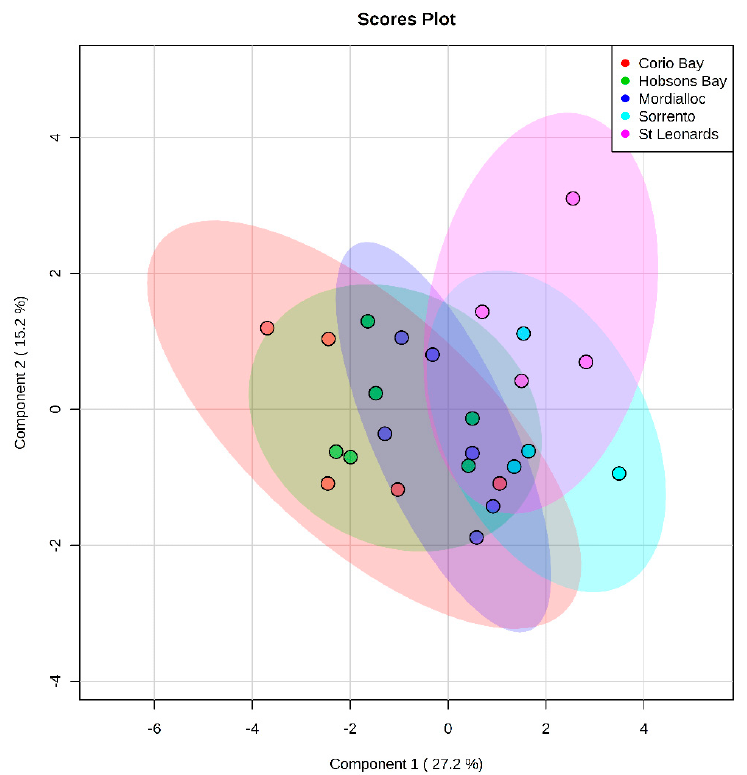
Figure 4. Partial least squares discriminant analysis (PLS-DA) showing the separation of free fatty acid metabolites in the livers of female sand flathead collected at five sites in Port Phillip Bay, Victoria, Australia in March 2015. Cross validation results are in the Supplementary Materials as Figure S3 and Table S4.